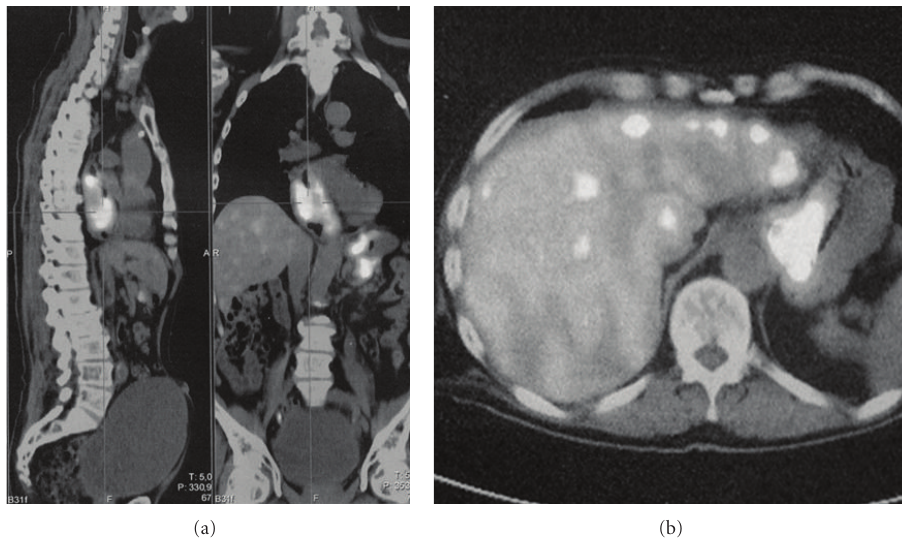
Figure 1: PET-TC scan showing the bulky esophageal mass (a) and the secondary di ff use liver involvement (b).